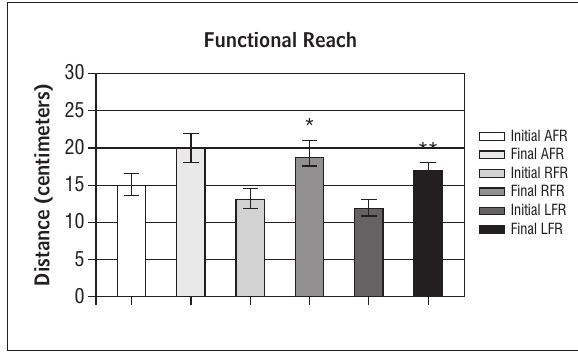
Figure 2 - Functional Reach